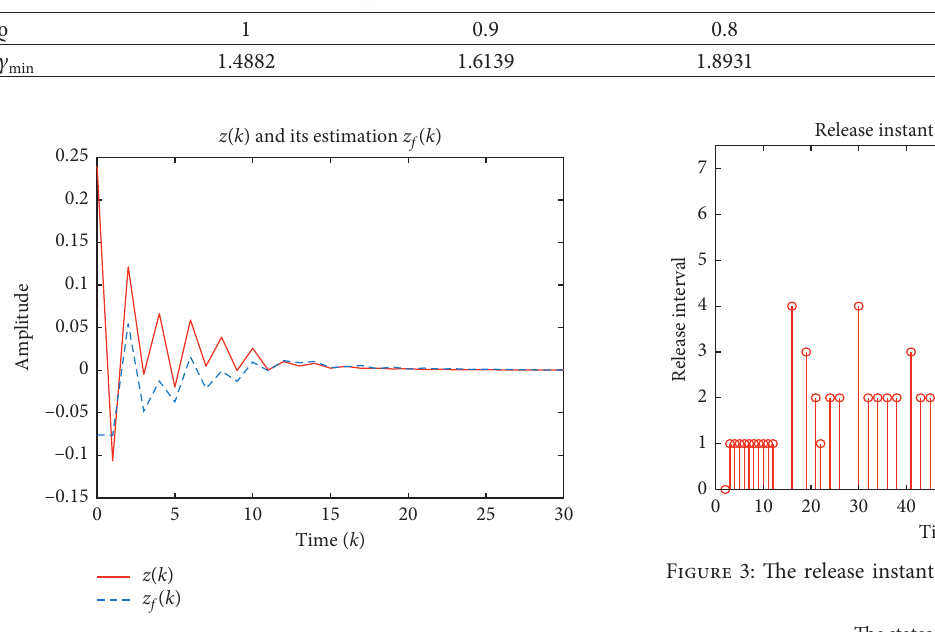
Figure 1: z ( k ) and z ( k ) in Case 1. f